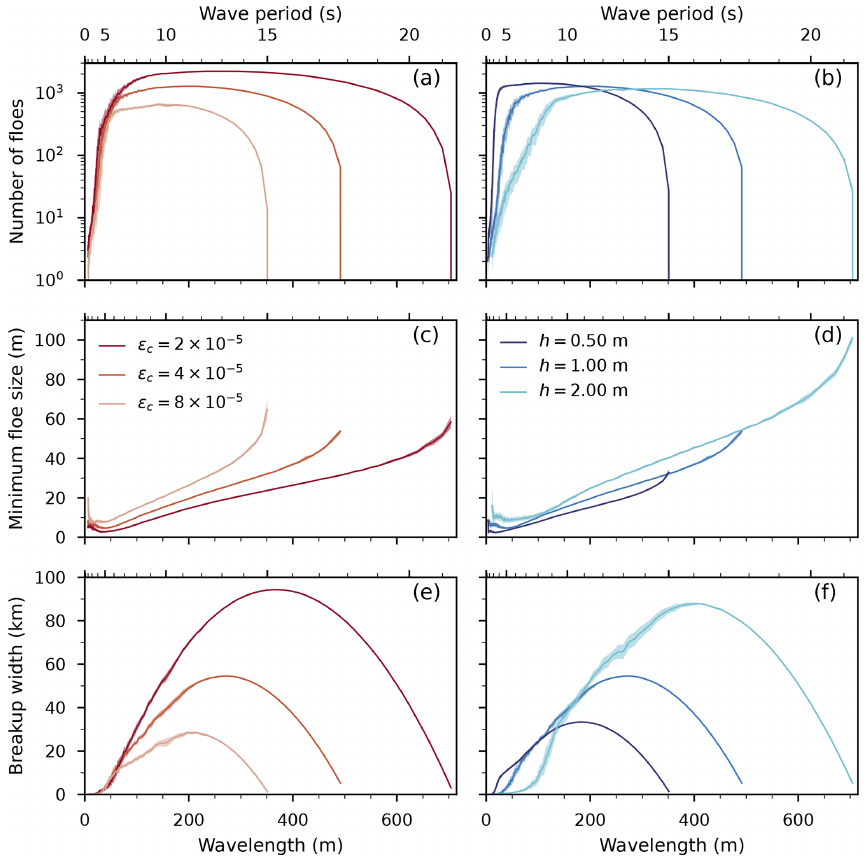
Figure 4. Various metrics at the end of a simulation. (a) Number of floes for different ε c . (b) Same as (a) but for different h . (c) Minimum floe size in the sample for different ε c . (d) Same as (c) but for different h . (e) Breakup width for different ε c . (f) Same as (e) but for different h . The breakup width is defined as the cumulated length of the broken-off floes. In (a) , (c) , and (e) h = 1m; in (b) , (d) , and (f) ε c = 4 × 10 − 5 ; T = 8s, a = 50cm for all panels. The wavelength axis corresponds to the open-water propagating wavelength at a given T . Darker hues denote weaker ice (lower strain threshold, lower thickness), and lighter hues denote stronger ice. The plotted lines are ensemble average; the shaded areas indicate 1 standard